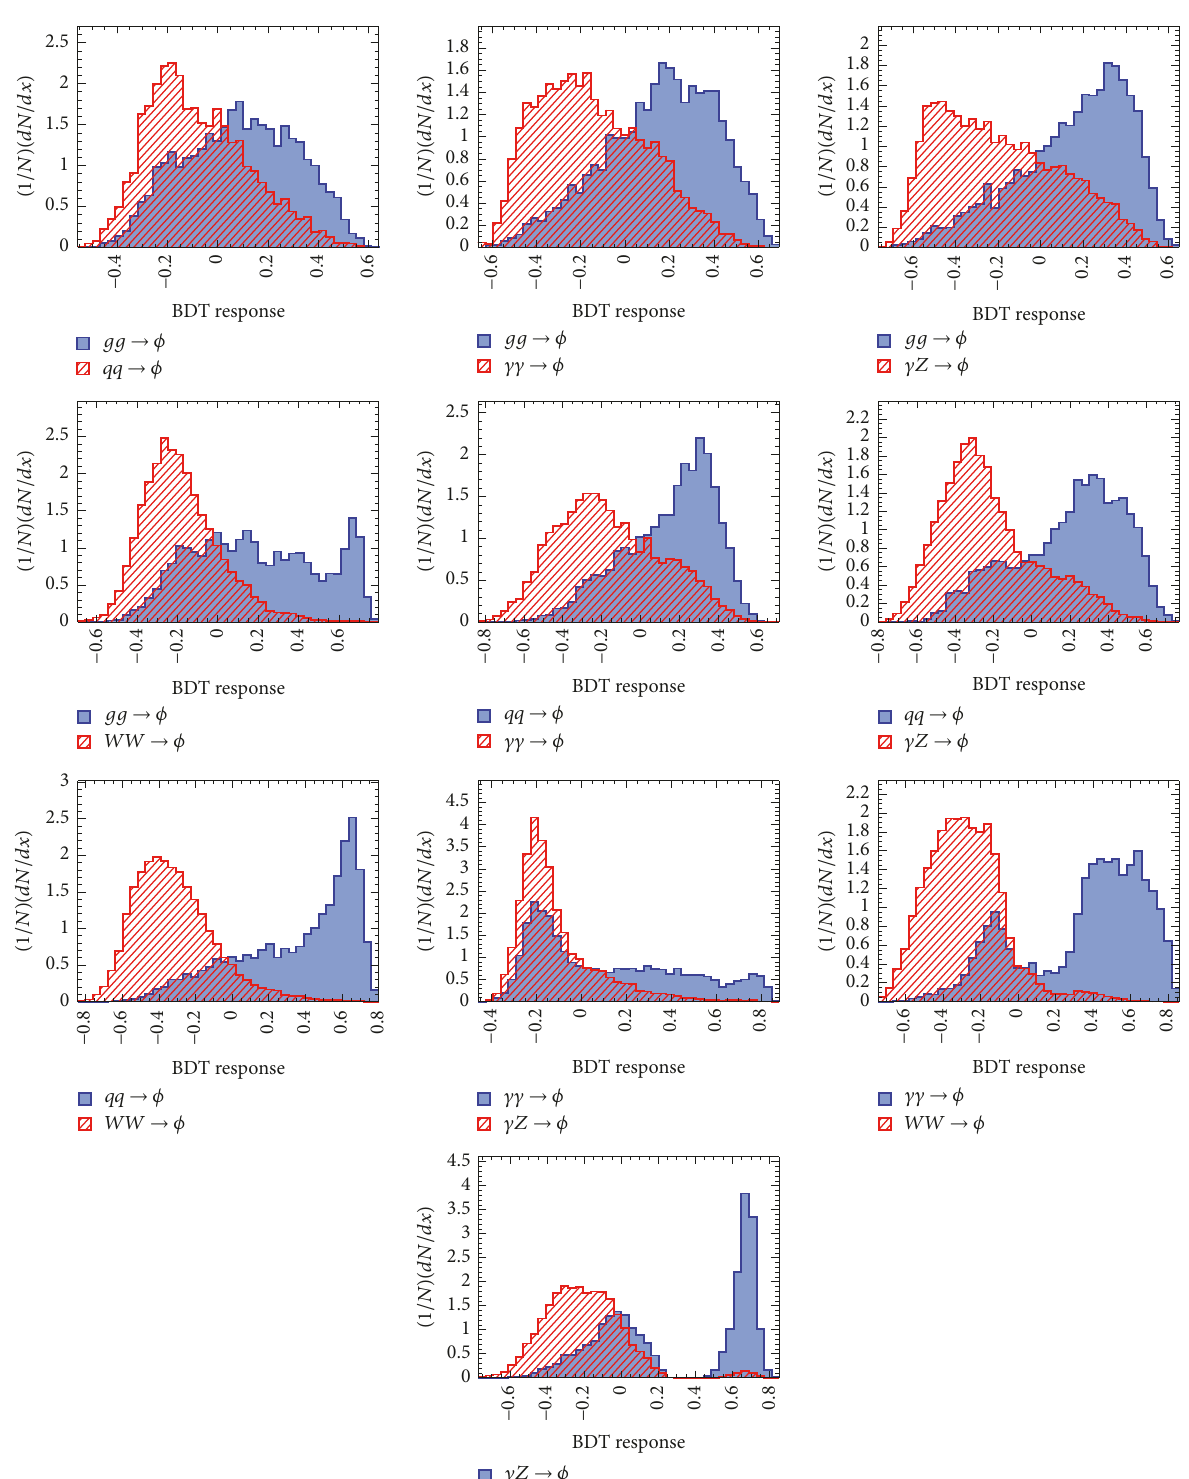
Figure 7: BDT responses of two different production modes at a time. These are obtained using a MVA with twelve input variables as listed in Table 2 for 𝑀 Φ = 1 TeV at the 13TeV LHC. Diphoton events are selected by applying |𝑀 𝛾𝛾 − 𝑀 Φ | < 150 GeV cut in addition to the ATLAS selection cuts as listed in the